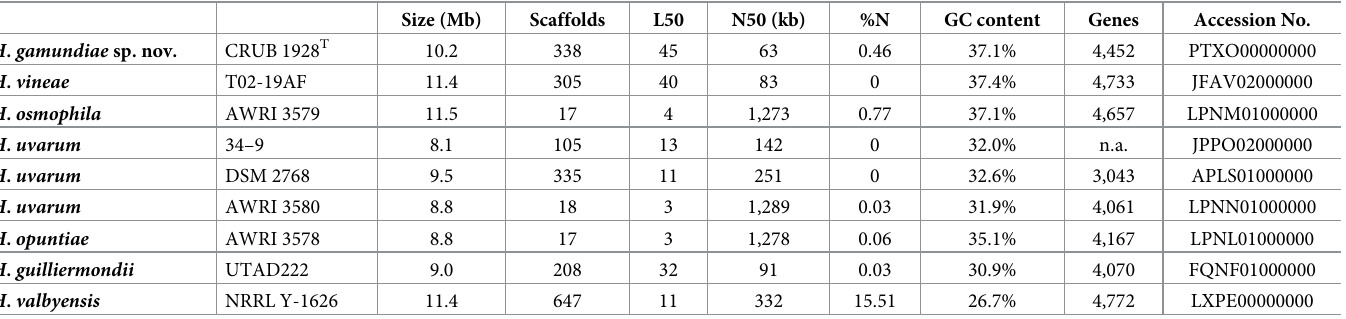
Table 1. Comparative analysis of genomes, assemblies, and gene statistics for Hanseniaspora gamundiae sp. nov. and other Hanseniaspora species. Size (Mb)